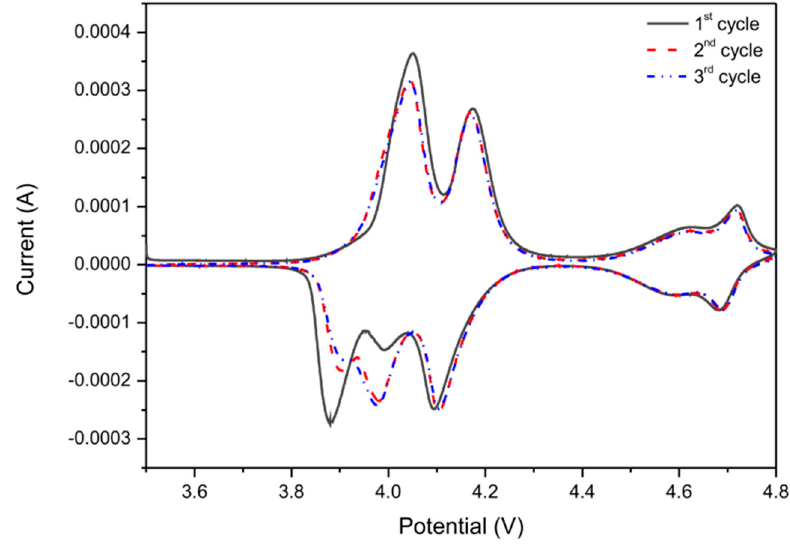
Figure 8. The cyclic voltammetry curves for a LMN1OS electrode with a scan rate of 0.05 mV·s − 1 .